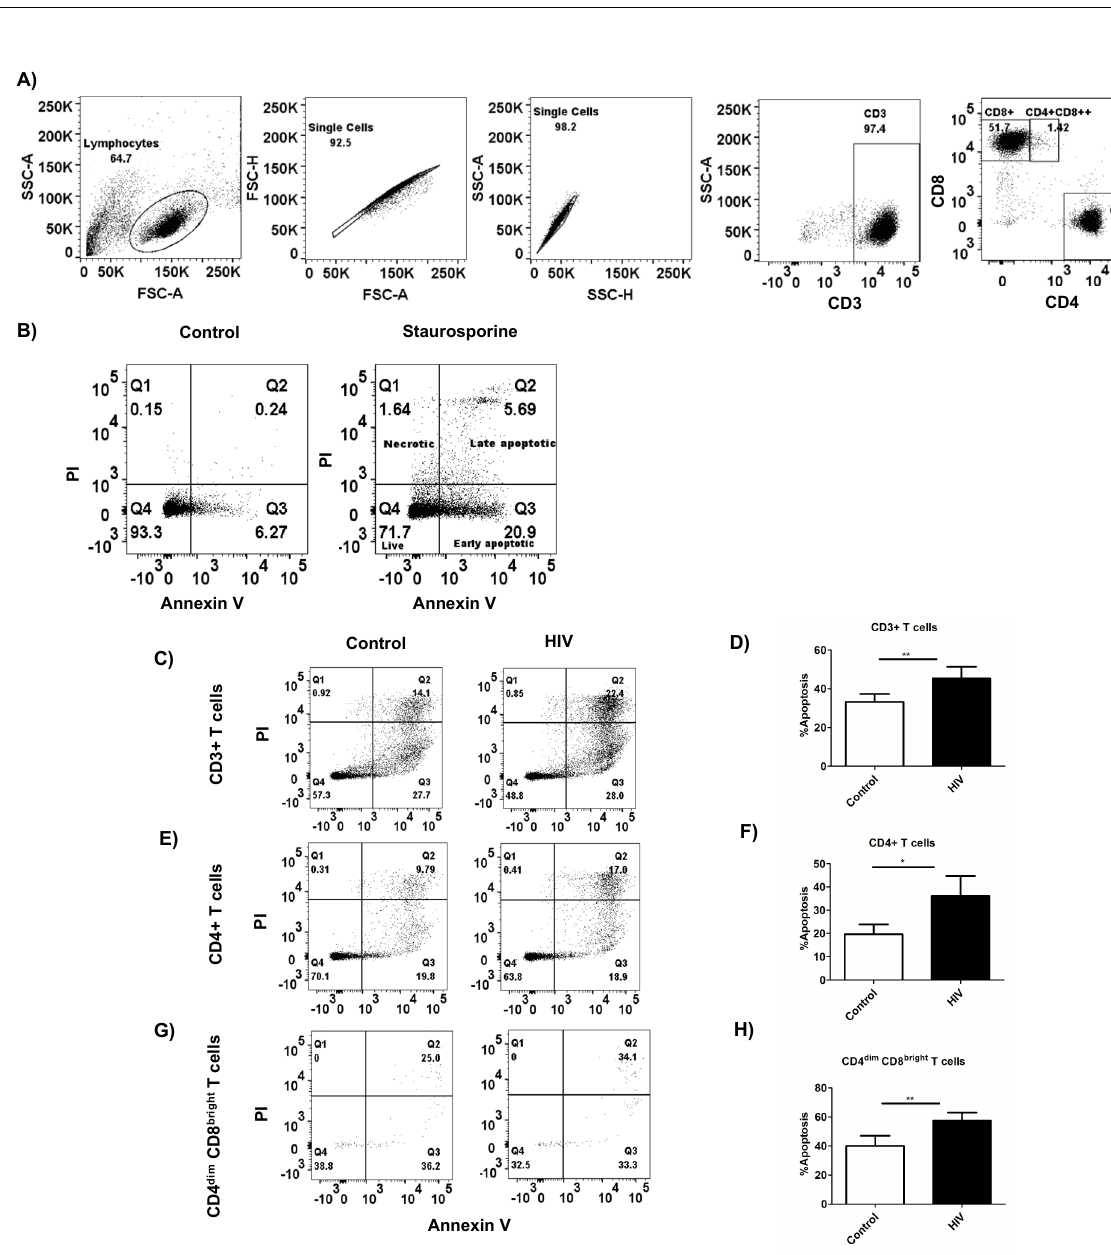
4 of 12 at least three times and data were represented as means, medians, or fold changes with the standard error of mean (SEM), with p ≤ 0.05 considered statistically significant. 3. Results HIV infection induces apoptosis in CD4+ and CD4 DIM CD8 BRIGHT T cells: To deter- mine the extent of HIV-induced cell death, we infected activated PBMCs with HIV and measured apoptosis 6 days post infection using an annexin/PI flow-based assay. The gat- ing strategies used on lymphocyte, singlet, CD3+, CD4+, and CD4 dim CD8 bright T cells were as shown in Figure 1A. Staurosporine (1 µM), an apoptosis-inducing agent through caspase-dependent and -independent pathways [29], was used as a positive control to set gates on live, early, late apoptotic, and necrotic populations (Figures 1B and S1A). Stauro- sporine at 1 µM exhibited a wide range of killing (25–75%) in activated PBMCs, which could be attributed to donor variability (Figure S1A). By measuring the percentages of total apoptosis (early and late apoptosis), we found that approximately 30–50% of total CD3+ T cells, 30–45% of CD4+ T cells, and 30–70% of CD4 dim CD8 bright T cells were positive for apoptosis in the presence of HIV, which was significantly higher than the basal level in uninfected control populations (Figure 1C–H). To further confirm the effect of HIV in- fection on PBMCs, we evaluated the ratios of CD4–CD8 T cells in PBMCs before and after infection. The CD4 percentage was downregulated post HIV infection, although it did not reach statistical significance, while CD8+ and CD4 dim CD8 bright T cells percentages increased